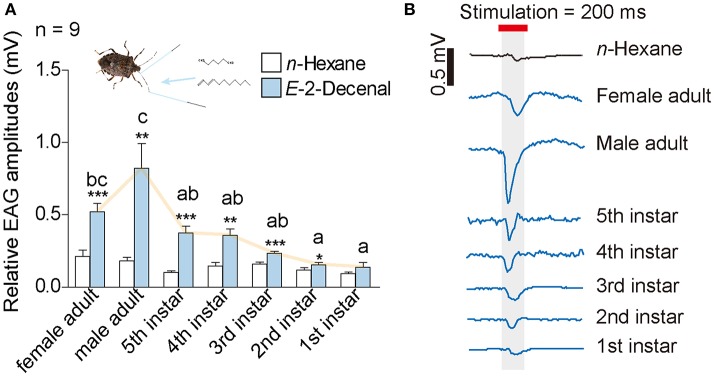
Results from EAG tests of H. halys. (A) A dosage of 10 μg (E)-2-decenal was used as treatment, and 10 μl n-hexan was used as control. Lower case letters indicate significant differences among H. halys stages in terms of EAG responses toward (E)-2-decenal [GLM and Tukey HSD, F(6, 61) = 10.09, P < 0.0001]. Asterisks indicate significant higher EAG responses of H. halys antennae toward (E)-2-decenal compared with n-hexane (t-tests, female adult: t = 7.7, P < 0.0001; male adult: t = 3.9, P = 0.0036; fifth instar nymph: t = 6.0, P = 0.0002; fourth instar nymph: t = 3.4, P = 0.0086; third instar nymph: t = 5.3, P = 0.0005; second instar nymph: t = 2.6, P = 0.03; first instar nymph: t = 1.9, P = 0.091). (B) Example traces of EAG responses from each stage and gender of H. halys. Original voltage data can be found in Data S1.